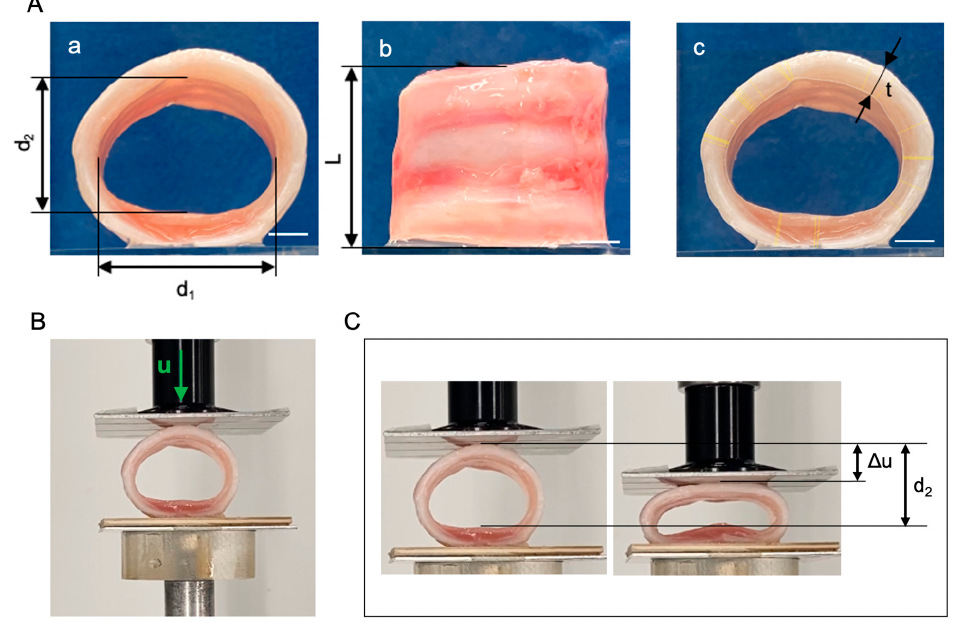
Figure 1. ( A ) Ring-like sample of trachea for mechanical testing, with measurements of the medio- lateral (d 1 ) and proximal-distal (d 2 ) diameters ( a ), the length of the segment L ( b ) and the tracheal wall thickness t ( c ). Yellow segments refer to the shortest distance between the inner and outer outline of the sample section in 30 random points. Scale bars = 5 mm. ( B ) Experimental set-up for compression tests with trachea sample between two flat plates. The displacement Δ u of the upper plate is applied along the distal-proximal direction. ( C ) Undeformed and deformed trachea samples with reference to the plate displacement Δ u and the initial diameter d 2 .